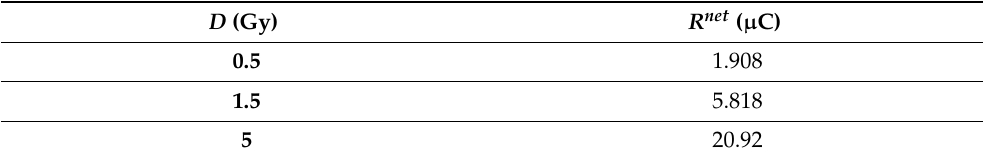
Table 3. Measured net values for each dose point when TLDs were exposed to Cobalt-60. Relative uncertainties on R net are expressed in Table 4.